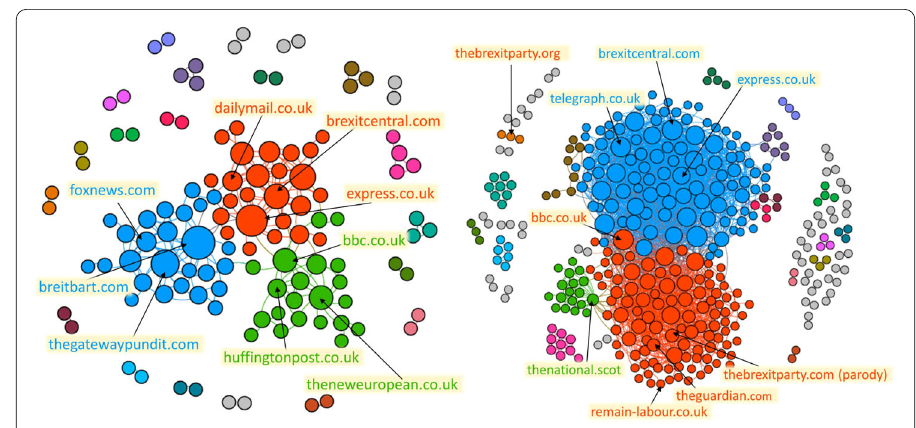
Figure 9 The projected networks of URLs used by bots (left) and by suspended users (right) for the whole period we consider. The suspended users are more organized in their patterns of retweets of